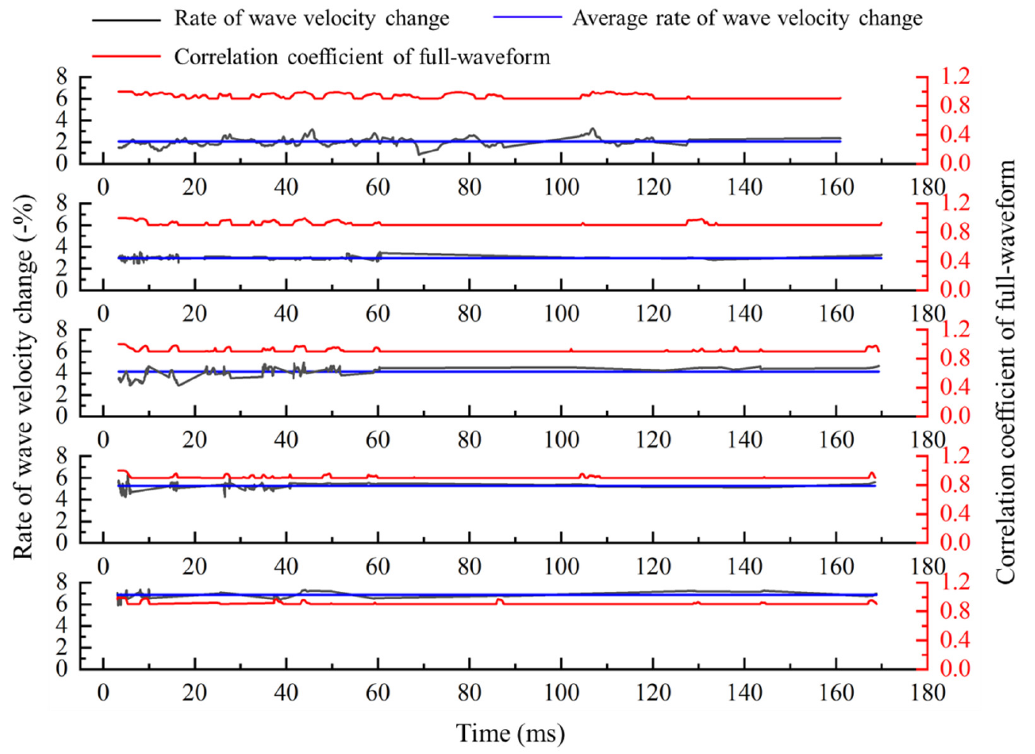
Figure 9. Rate of wave velocity change calculated by the method which only improves the time-shift solution.